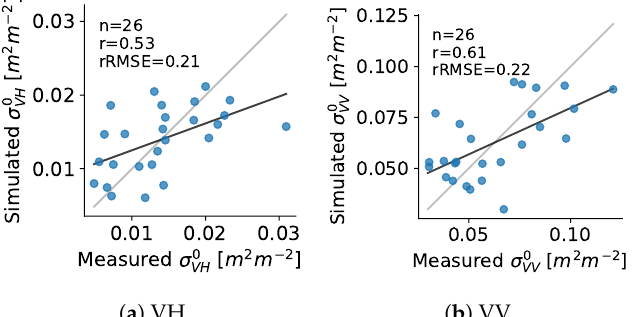
Figure 10. Results from the LOOCV for the calibration of the WCM with C-band data in ( a ) cross- polarization, VH; ( b ) vertical co-polarization, VV.